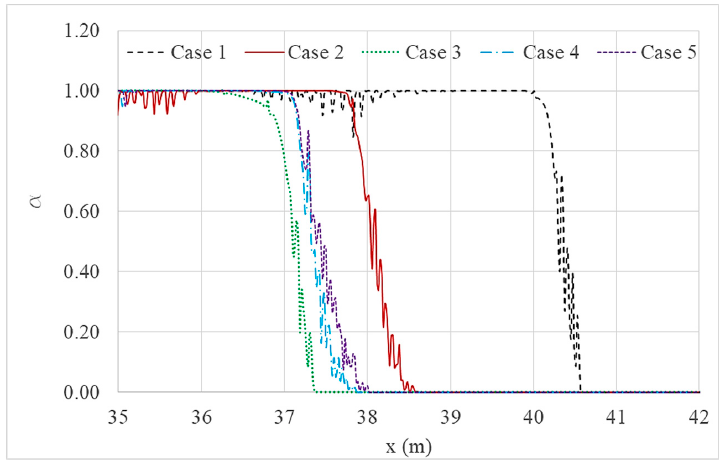
Figure 17. Comparison of wave induced inundation for each simulation case with different spacings between wall and